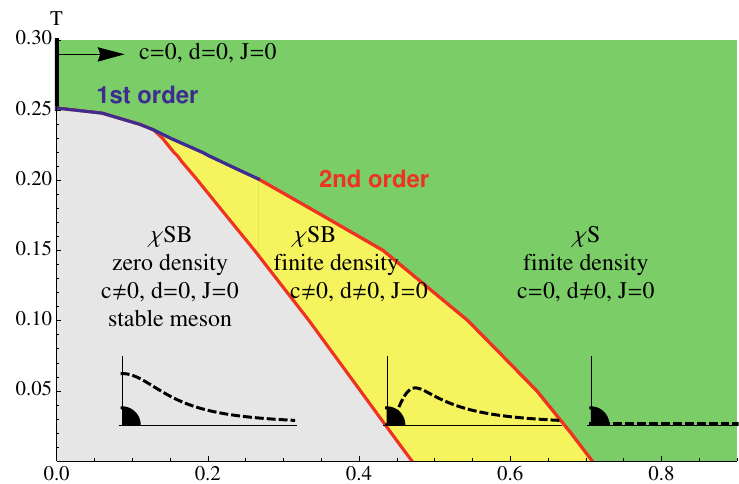
Figure 3. The phase diagram for the N = 4 SYM theory with N = 2 quark hypermultiplets in the presence of a magnetic